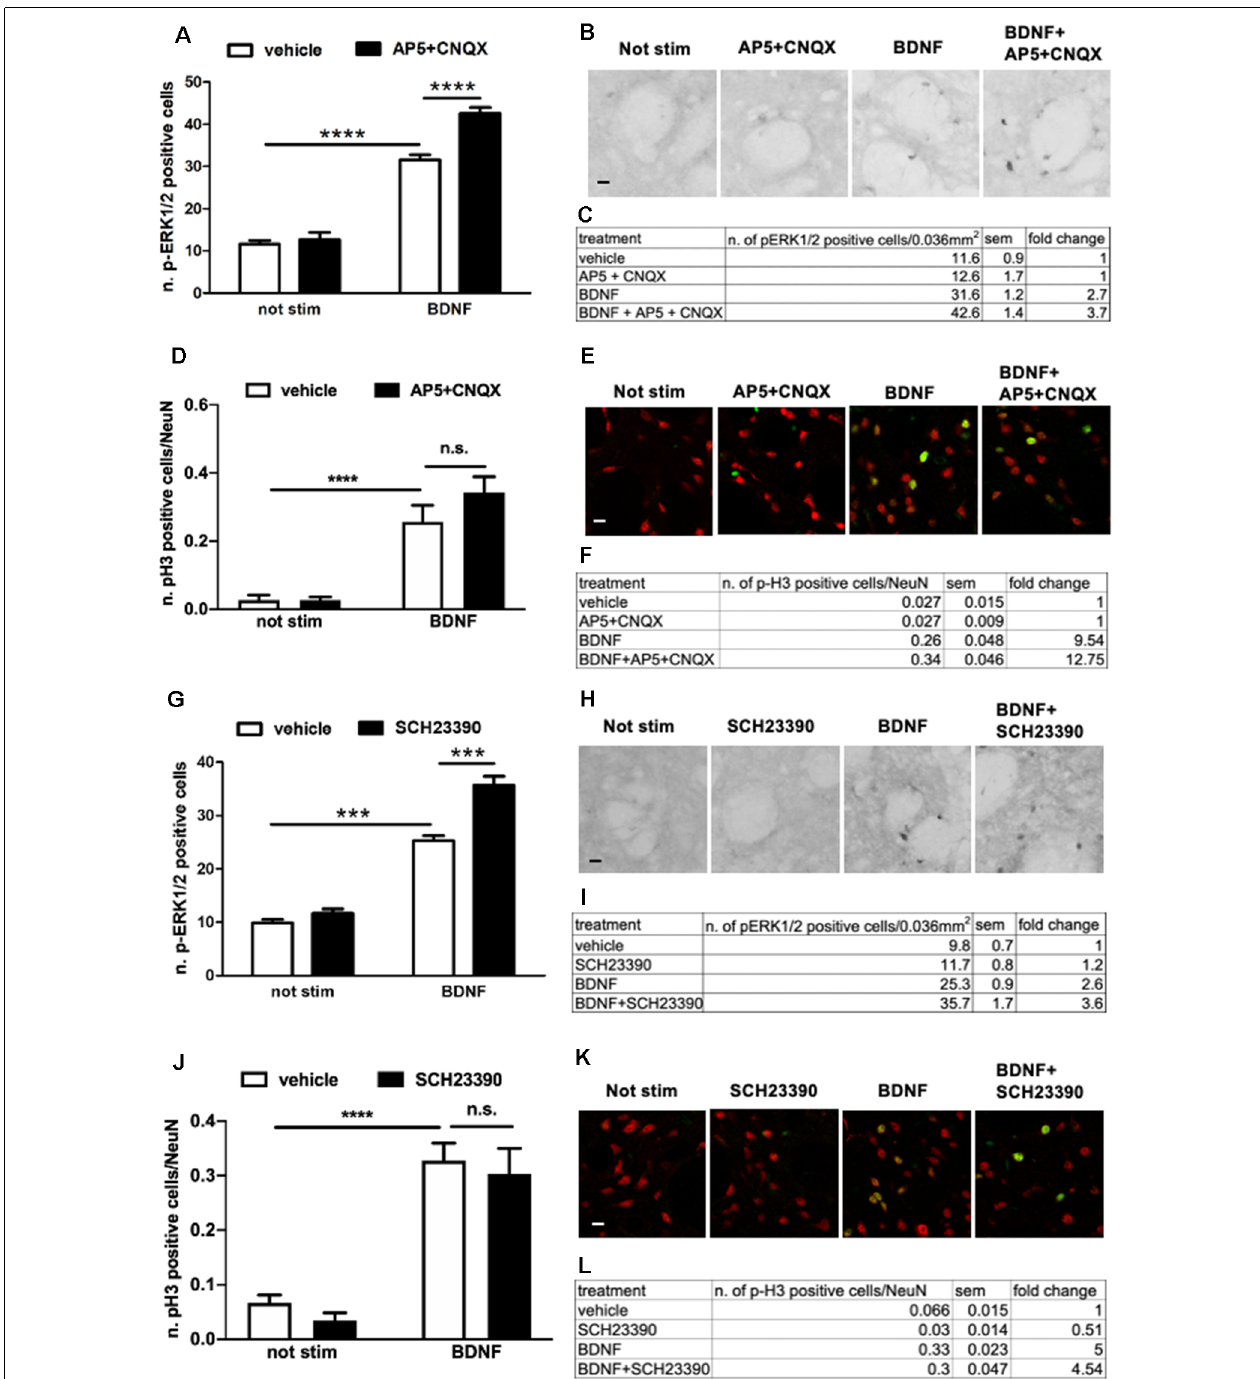
FIGURE 5 | (A,C) Pre-treatment with glutamate antagonists CNQX 10 µ M and AP5 10 µ M increases BDNF-induced ERK activation (two-way ANOVA, effect of BDNF F (1,28) = 341.384, p < 0.0001, effect of AP5/CNQX F (1,28) = 19.969, p < 0.0001, effect of interaction F (1,28) = 13.553, p = 0.001. Bonferroni’s post hoc , not stimulated vs. BDNF: **** p < 0.0001, BDNF vs. BDNF + AP5 + CNQX: **** p < 0.0001). Data are shown as mean ± SEM, n = 8 per group. The values of mean, SEM and fold change relative to not stimulated control are shown in panel (C) . (B) Representative pictures of anti-phospho-ERK1/2 immunohistochemistry. Scale bar: 50 µ m. (D,F) Pre-treatment with glutamate antagonists CNQX 10 µ M and AP5 10 µ M has no effect on BDNF-induced H3 activation (two-way ANOVA, effect of BDNF F (1,23) = 50.80, p < 0.0001, effect of AP5/CNQX F (1,23) = 1.272, p = 0.2710, effect of interaction F (1,23) = 1.279, p = 0.2697. Bonferroni’s post hoc , not stimulated vs. BDNF *** p = 0.0007, AP5 + CNQX vs. BDNF + AP5 + CNQX **** p < 0.0001, BDNF vs. BDNF + AP5 + CNQX p = 0.2082). Data are shown as mean ± SEM. Not stimulated and AP5 + CNQX: n = 6 per group, BDNF: n = 7, BDNF + AP5 + CNQX: n = 8. The values of mean, SEM, and fold change relative to